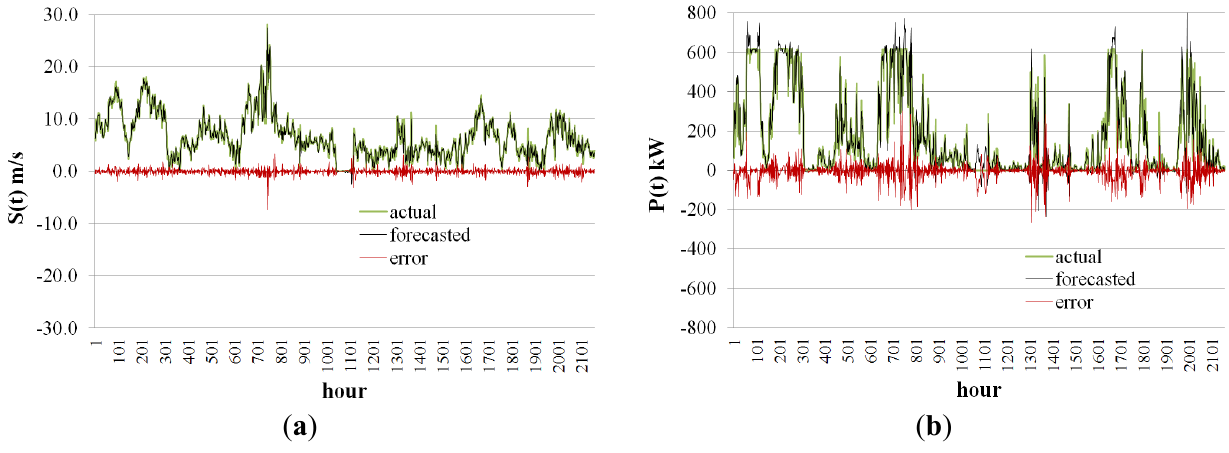
Figure 8. Actual/forecasted wind speeds/powers and errors during the summer: ( a ) S( t ); ( b ) P( t ).